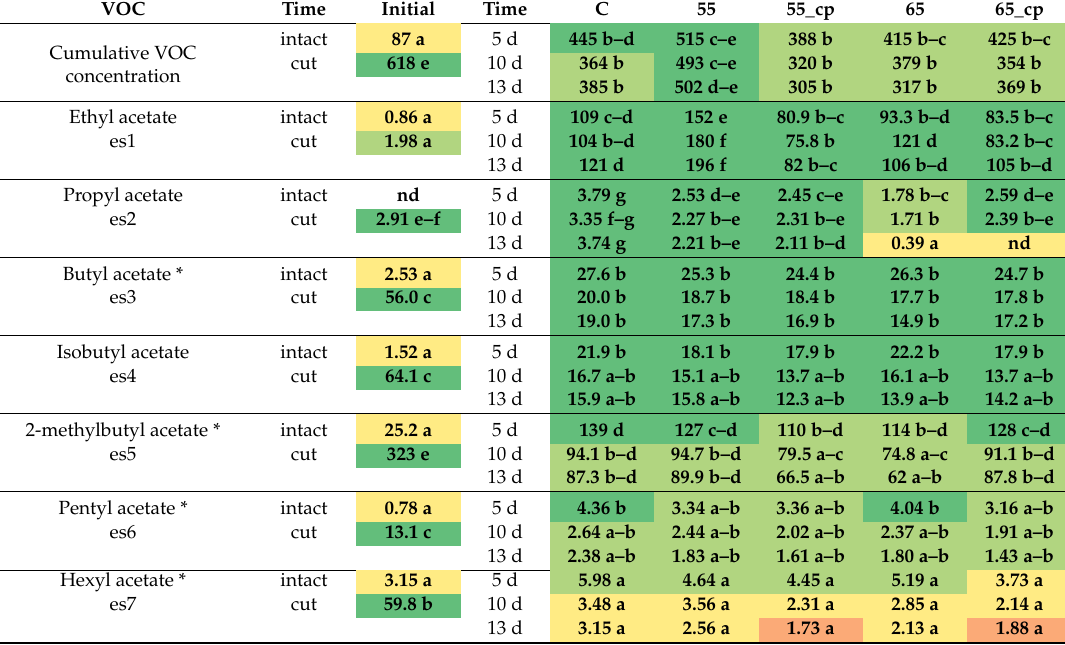
Table 2. Semi-quantitative concentrations (nL L − 1 ) of VOCs, emitted by intact, freshly cut (cut) and variously treated (C: control with chemical prevention; 55: 55 ◦ C sHWT without chemical